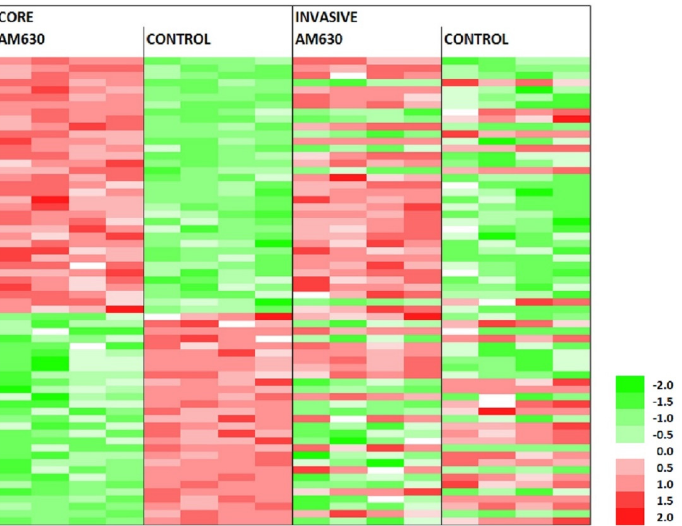
Figure 3. The probes that are significantly perturbed by AM630 in both the core and invasive margin cells. Probe levels are shown for which both the AM630 core and invasive cell expression change is above three standard deviations from the null. The total number of probes is 64 and there is a sig- nificant correlation between the responses in both cell types, with a Fisher exact test score of p < 0.004 (UU 28, UD 7, DU 13 and DD 16, where U = up regulated and D = down regulated). Pathway enrichment of the genes perturbed in the core population showed a clear up regulation of immune response genes and down regulation of cell cycle and metastatic pathways (see Table 3). In contrast, the weaker response in the invasive margin was asso- ciated with more modest pathway enrichment (see Table 4). However, of note was the down regulation of tumour invasiveness genes and the MYC oncogene signature indi- cated an anti-neoplastic AM630 activity in this context. Table 3. The positive and negative enrichment of pathways in the AM630 transcriptional response of the core cell population. AM630 up regulates an immune response together with TP53 and inter- feron and a down regulation of cell cycle and cancer-associated pathways. See Table S5 for a full list of enriched pathways. Up-Regulated Pathways Down-Regulated Pathways Z-Score